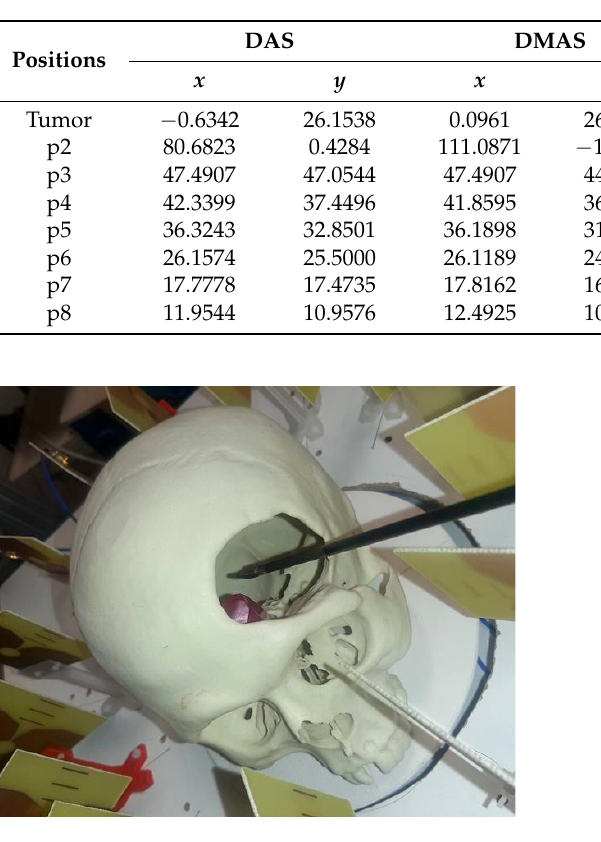
Table 1. Detected tool’s final-end coordinates (in mm).